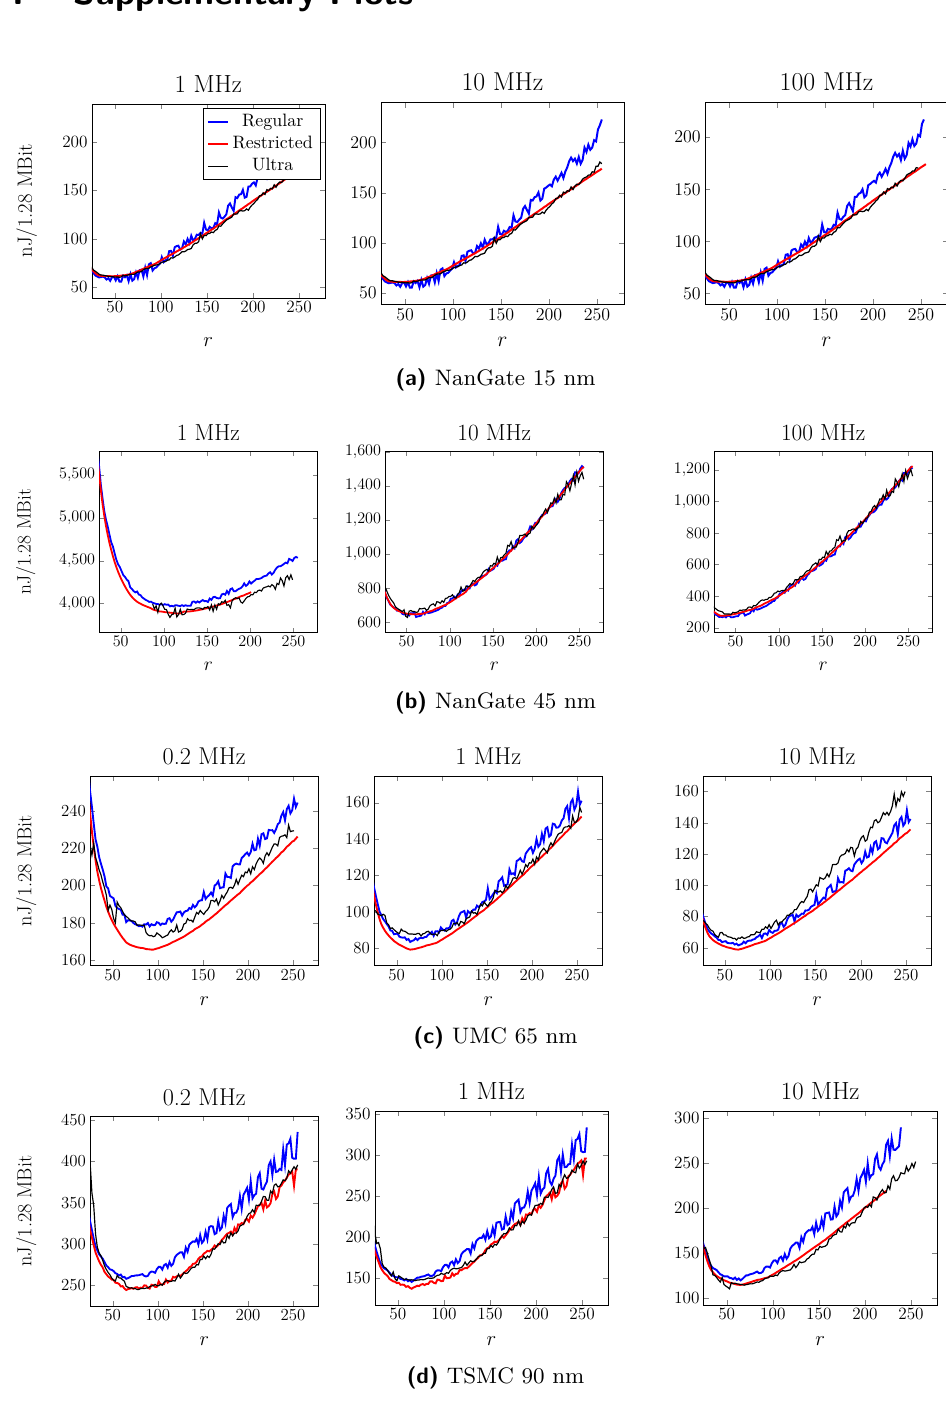
Figure 19: Energy consumption Grain-128